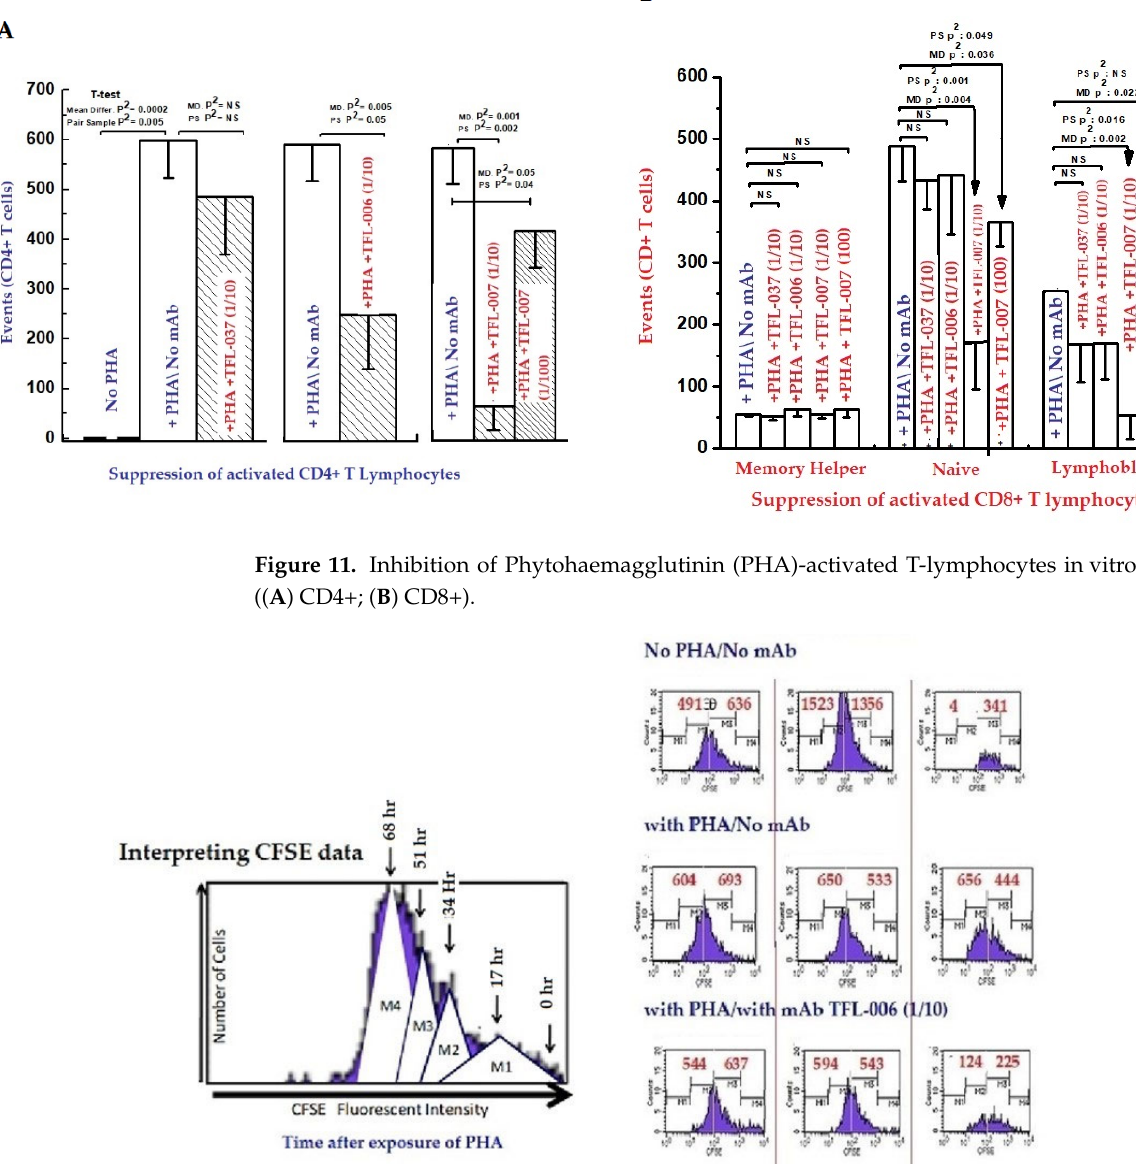
Antibodies 2022 , 11 , x FOR PEER REVIEW 28 of 44